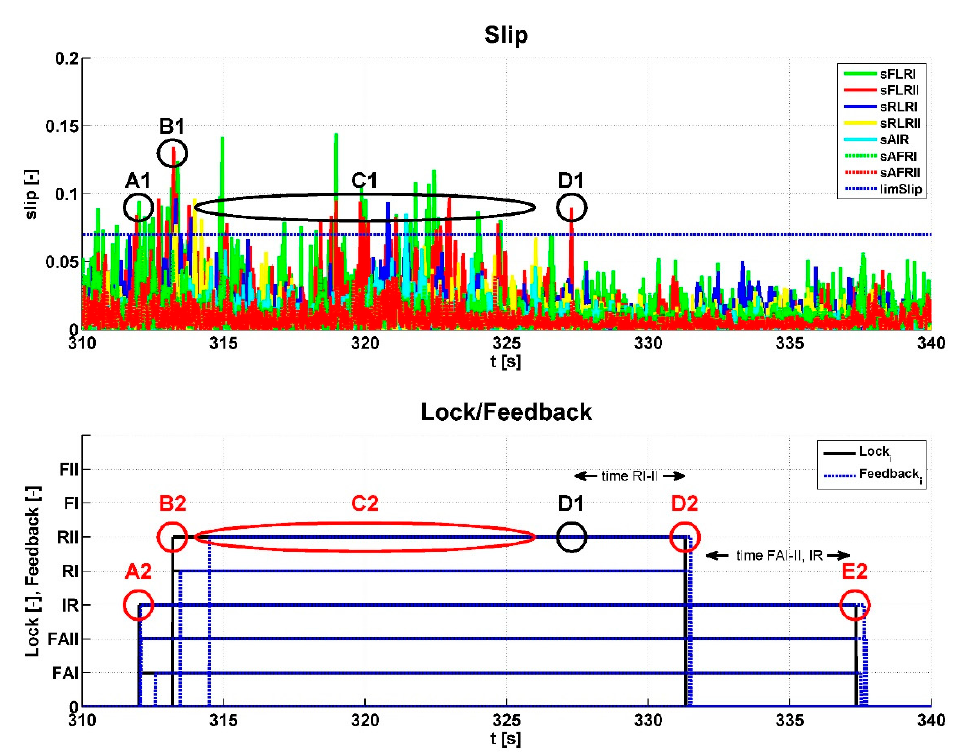
Figure 15. Status of lock (a value of 1 is represented by the indication of a particular actuator on the vertical axis)/unlock.